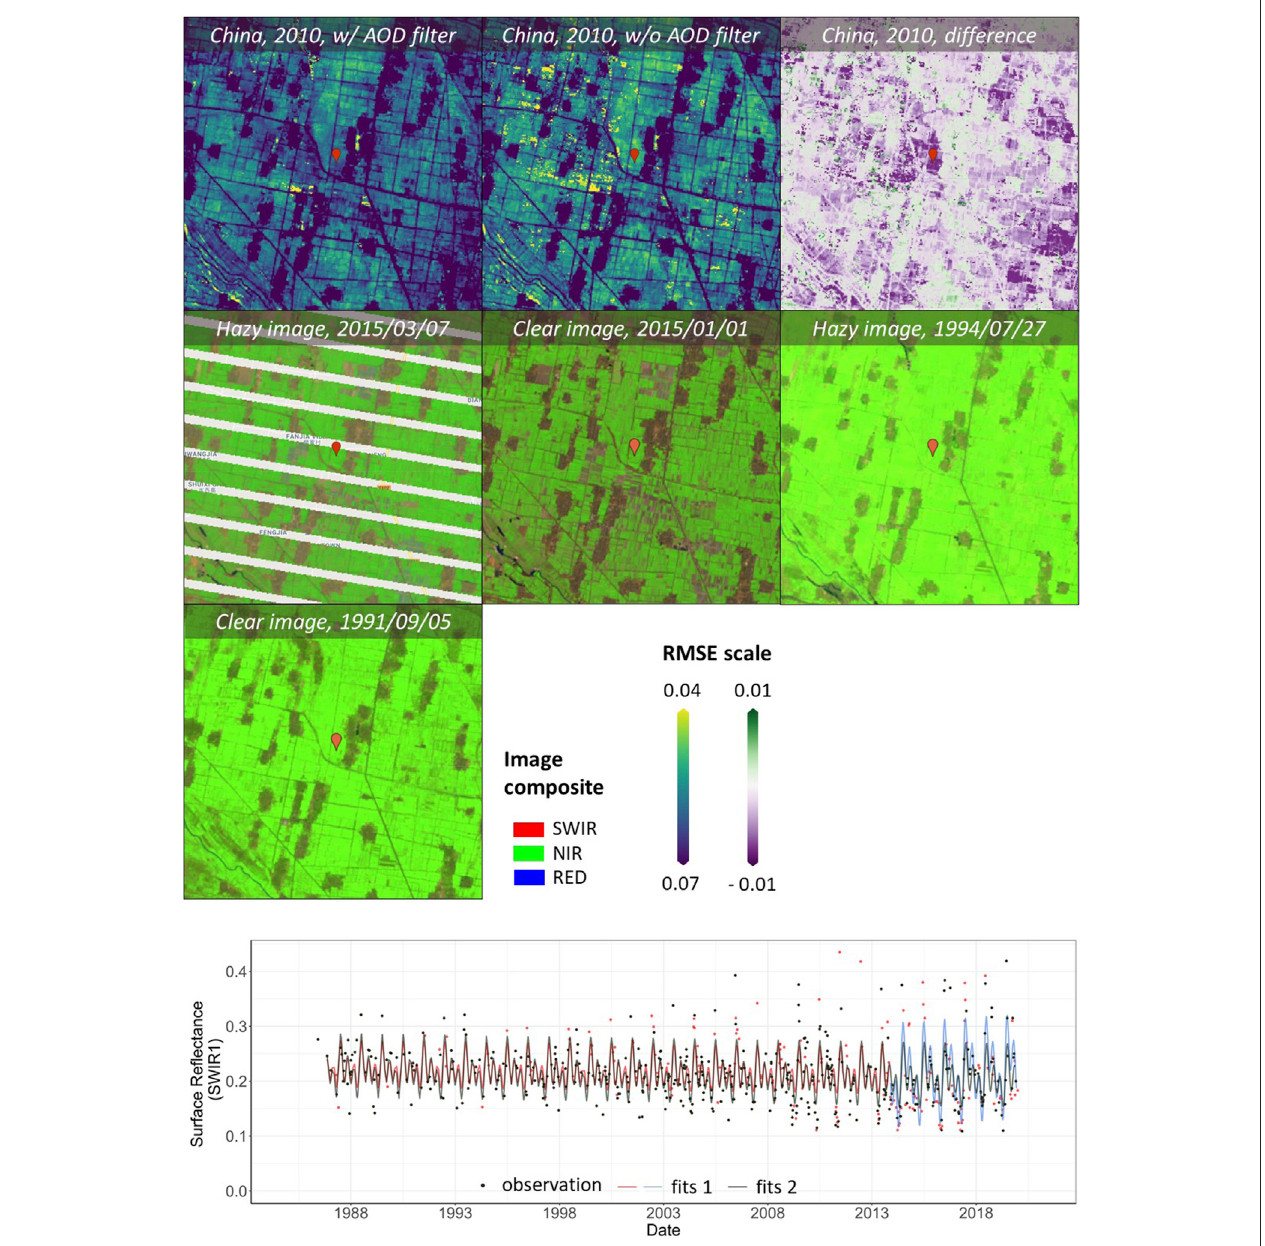
FIGURE6| ThetoprowareRootMeanSquareError(RMSE)mapsfromCCDCfor2010inHenanProvince,China.Fromthelefttoright,theyareRMSEmapswith anAOT > 0.3 fi lter,withoutanyAOT fi ltering,andthedifferencebetweenthetworesults.TheremainingthumbnailsareLandsatimagesonspeci fi cdates.The fi rsttwoare duringthewinterandtheothertwoarefromthesummer.Thetimeseriesplotincludestwocases:blackdotsandblackcurvescorrespondtoCCDCmodel fi tsusingAOT fi lter; red dots and red/blue curves correspond to CCDC model fi ts without using AOT fi lter (Lat: 34.2023; Lon: 114.3525).